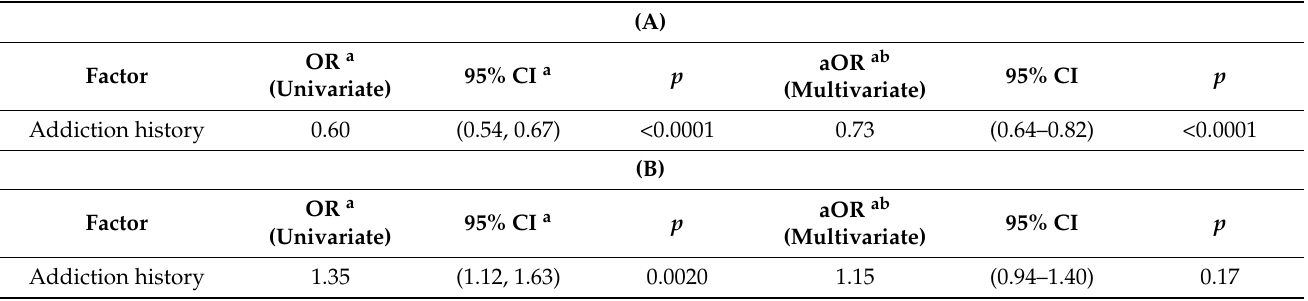
Figure 2. Viral hepatitis-related healthcare utilization. Table 3. A : Association between history of an addictive disorder and suboptimal (I + II) healthcare utilization. B : Association between history of an addictive disorder and grade II suboptimal healthcare utilization as opposed to grade I suboptimal HCU.